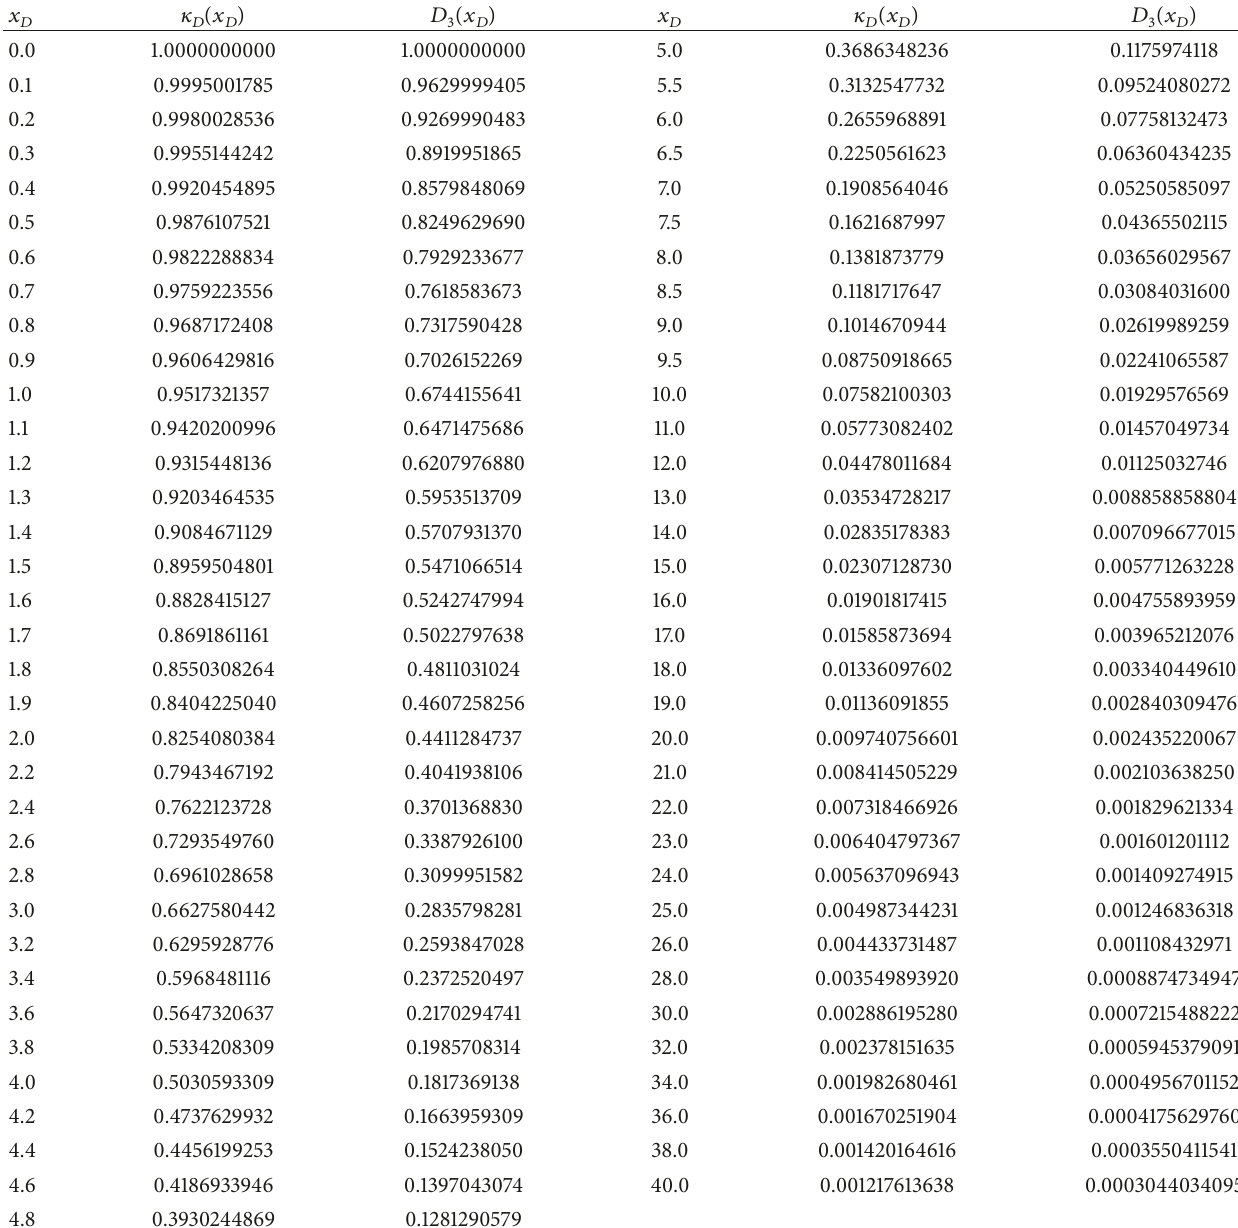
Table 7: High-accuracy sample values for Debye’s normalized heat capacity shape function, 𝜅 𝐷 (𝑥 𝐷 ) (A.1), which are directly comparable